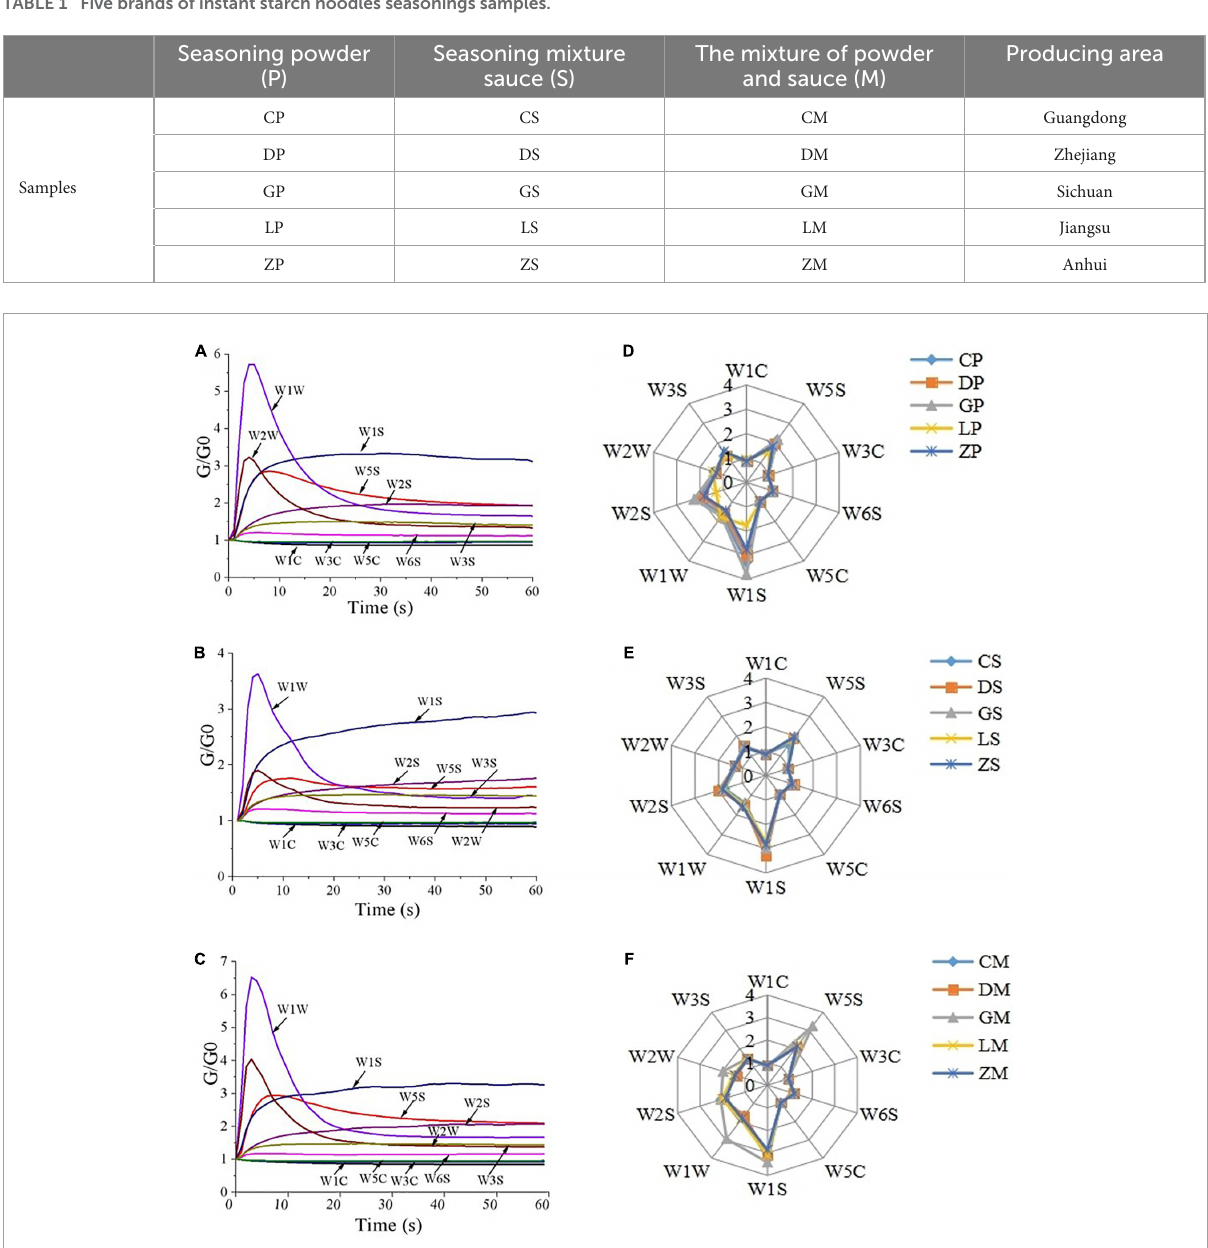
TABLE 1 Five brands of instant starch noodles seasonings samples.